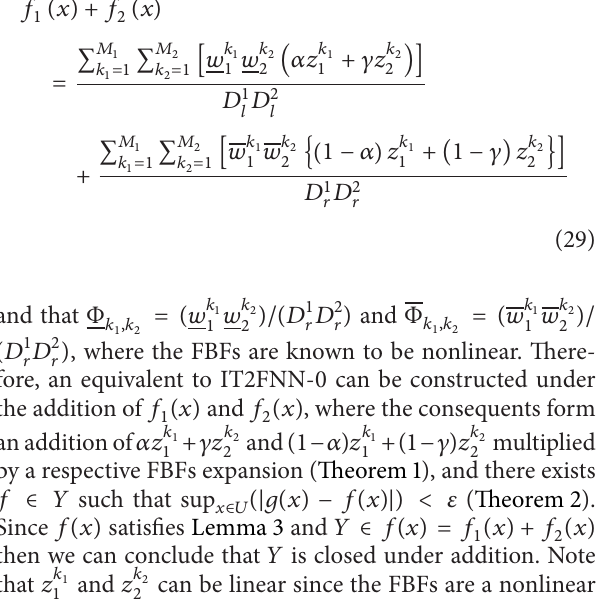
Figure 5: An example of the IT2FNN-0